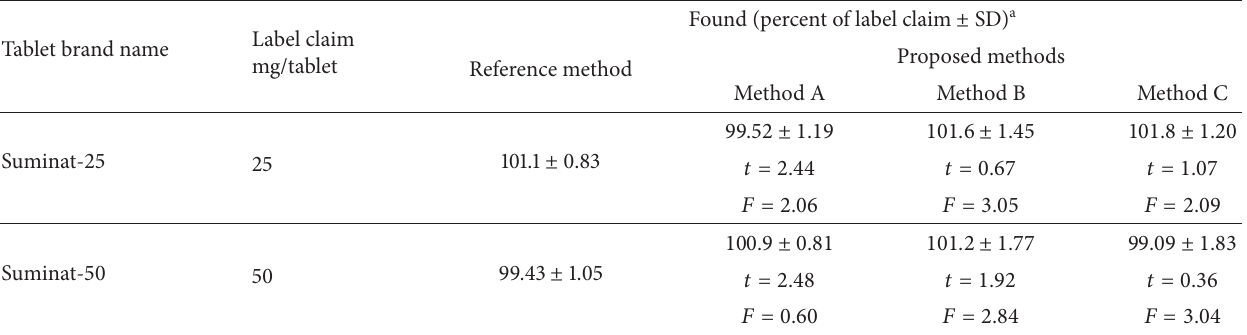
Table 5: Results of analysis of tablets by the proposed